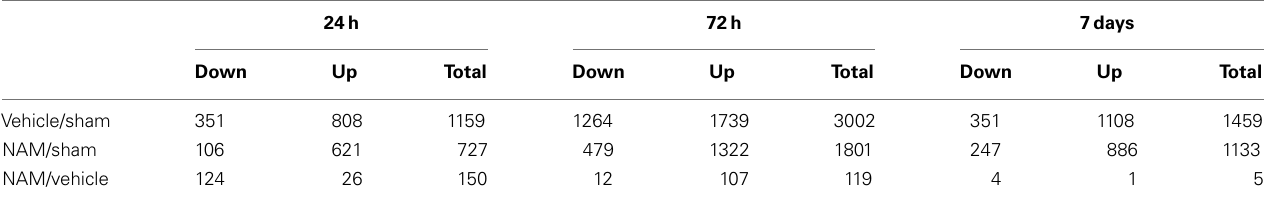
Table 1 | Brain gene expression data.